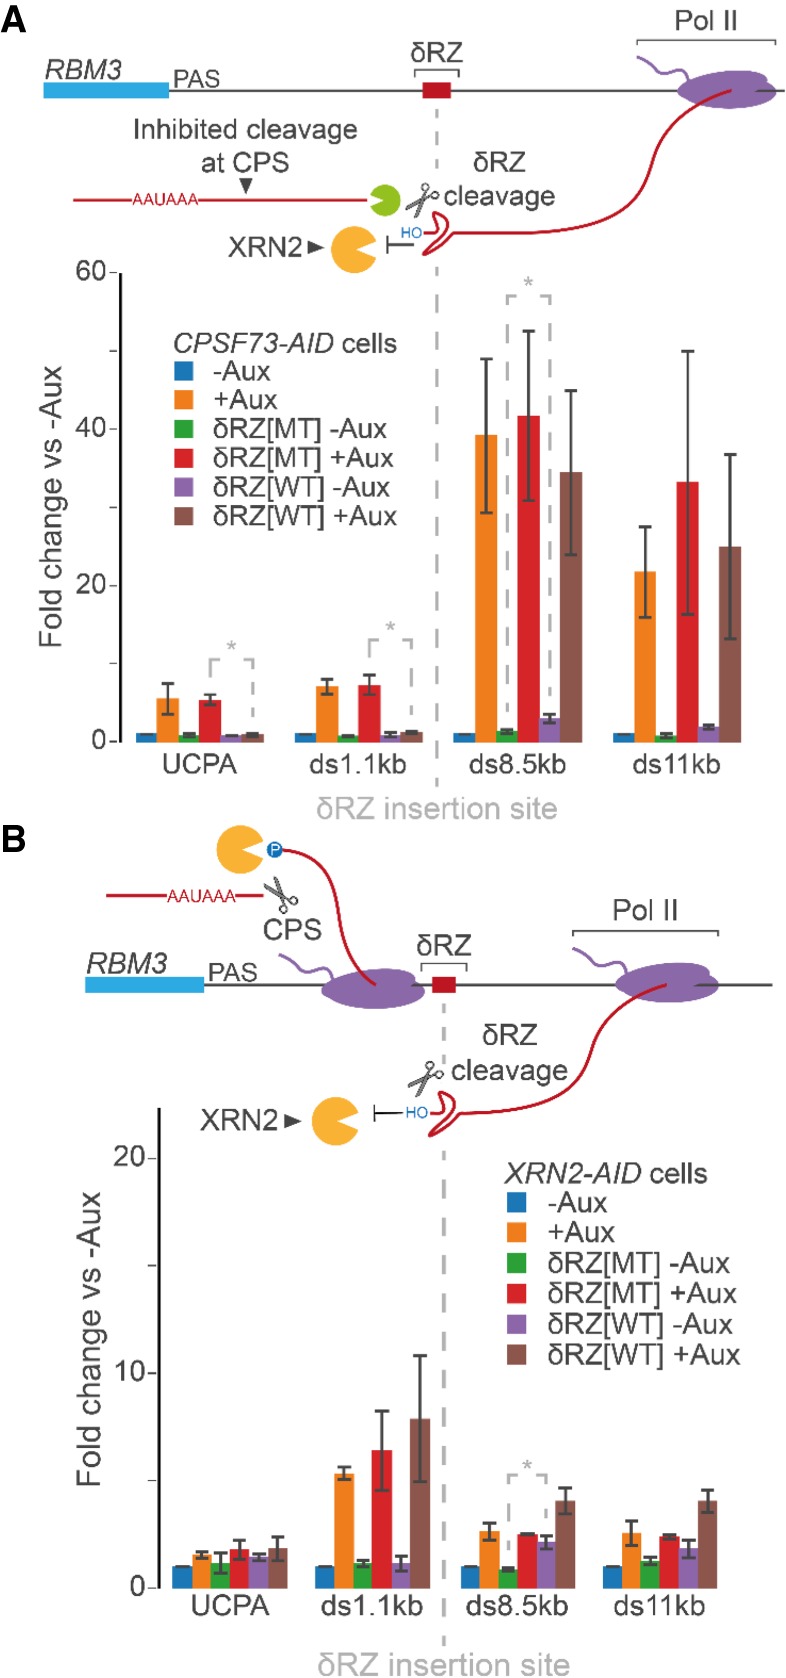
Pol II piles up over termination regions when XRN2 is depleted whereas CPSF73 loss induces runaway transcription. (A) qRT-PCR analysis of RBM3 readthrough in unmodified CPSF73-AID cells and CPSF73-AID cells modified at RBM3 by addition of δRZ[WT/MT] and then treated or not with auxin (3 h). The schematic shows the RZ insertion and predicted impact on RNA degradation. The graph shows fold change in RNA over each amplicon relative to unmodified CPSF73-AID cells not treated with auxin after normalising to spliced ACTB. n ≥ 3. Error bars are SEM. (*) P < 0.05 to highlight significance of smaller fold effect changes commented on in the main text. UCPA detects transcripts uncleaved at the PAS. (B) qRT-PCR analysis of RBM3 readthrough in unmodified XRN2-AID cells and XRN2-AID cells modified at RBM3 by addition of δRZ[WT/MT] and then treated or not with auxin (3 h). The graph shows fold change in RNA at each amplicon relative to unmodified XRN2-AID cells after normalizing to spliced ACTB. n ≥ 3. Error bars are SEM. (*) P < 0.05 to highlight significance of smaller fold effect changes commented on in the main text.